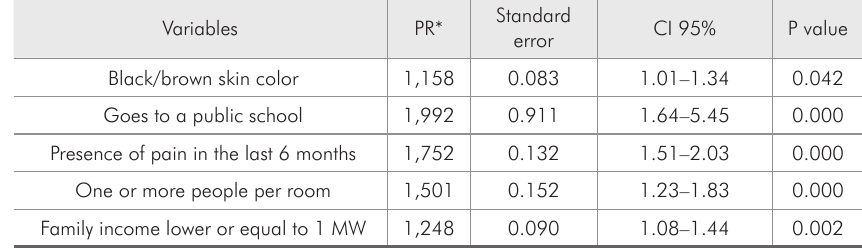
Table 3 - Multivariate analysis of the factors associated with the prevalence of untreated dental caries in 12-year-old schoolchildren living in the city of São